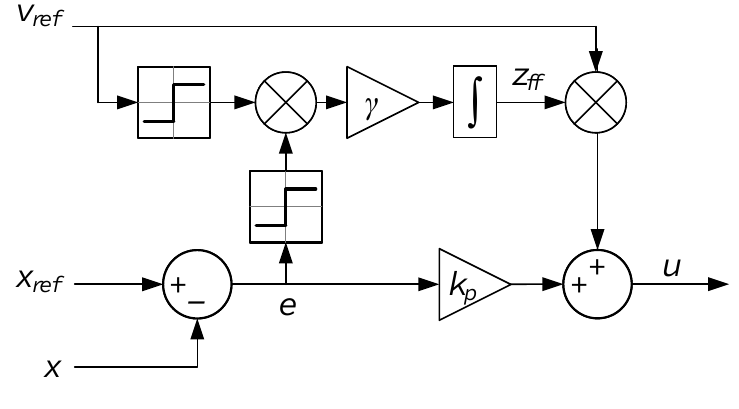
Figure 5. Sign-sign adaptive